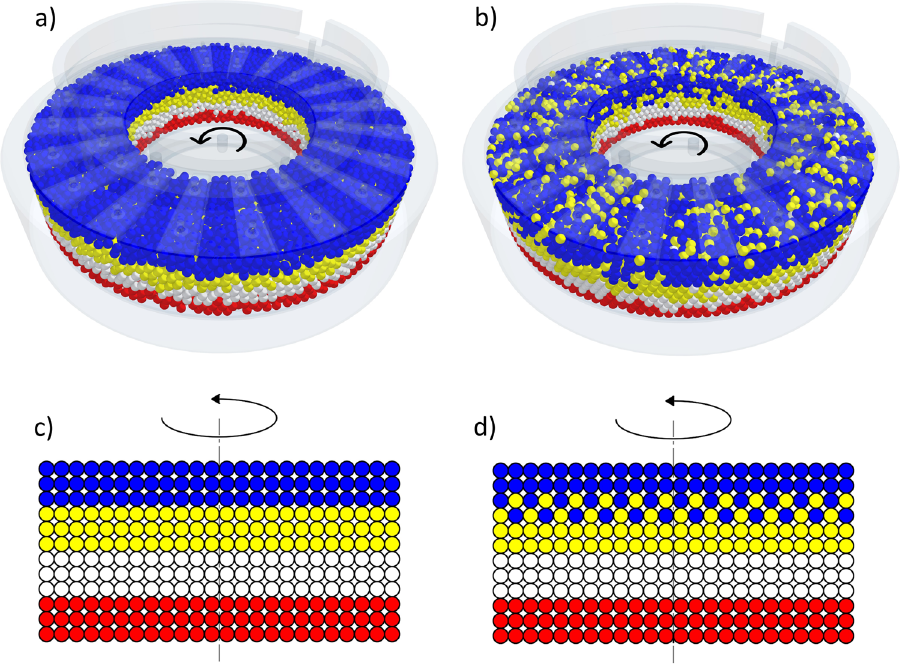
Figure 2. Particle displacement. ( a ) Initial position of the rotary test, ( b ) final position of the rotary test, ( c ) schematic representation of the initial position, ( d ) schematic representation of the displacement.